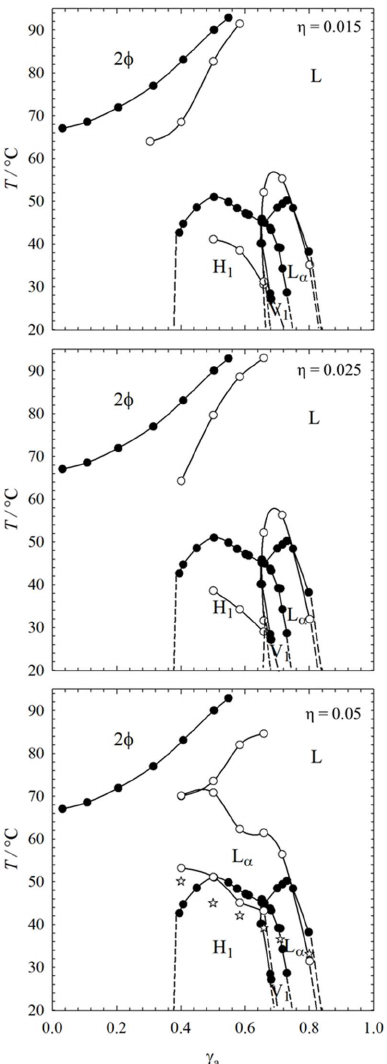
Figure 1. T – γ a phase diagrams of the binary system H 2 O–C 12 E 7 (black circles) and of the systems H 2 O–C 12 E 7 –12-HOA (open circles) with 12-hydroxyoctadecanoic acid (12-HOA) mass